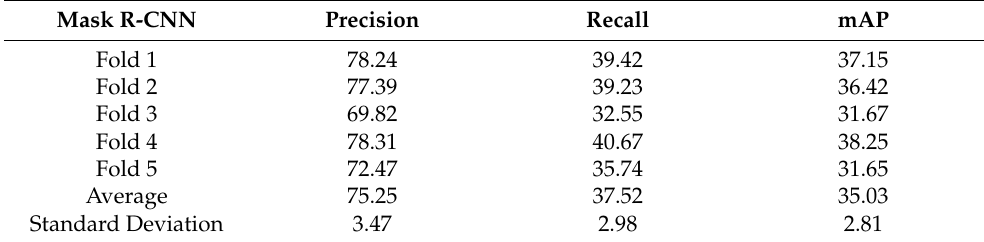
Table 3. Results of 5-fold cross-validation from Mask R-CNN.